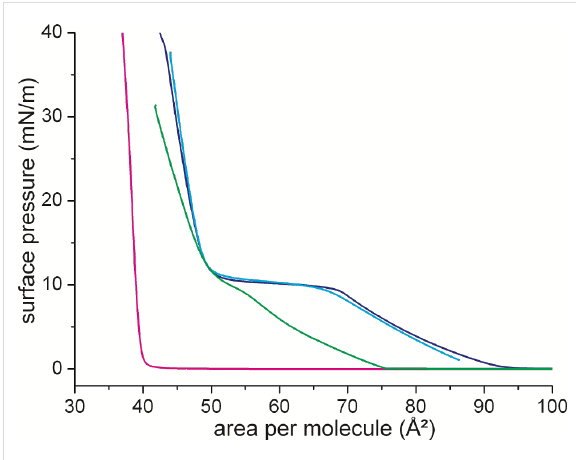
Figure 4: Isotherms of DPPC (dark blue), cholesterol (magenta), DPPC/cholesterol (8:2 mol/mol, green), and DPPC/flipper (8:2 mol/mol, blue) measured on water at 25 °C. The area in the mix- ture is given as area per DPPC